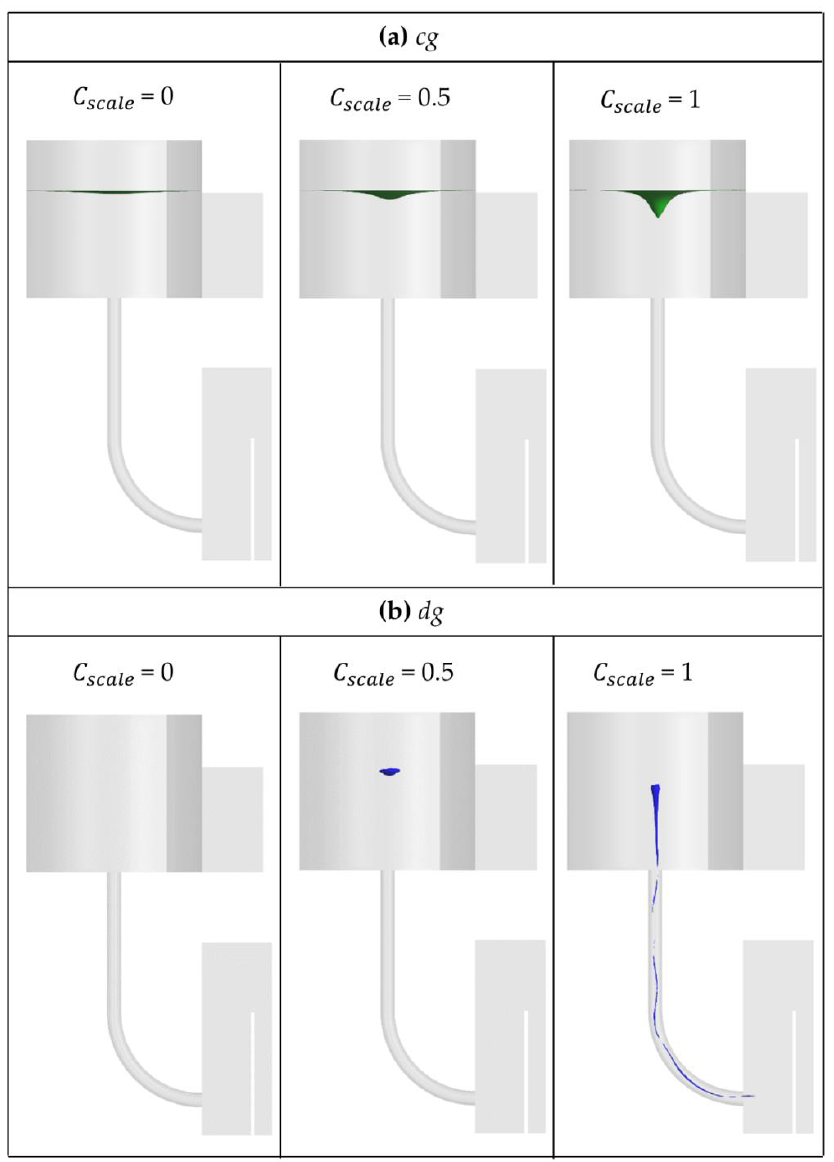
Figure 4. ( a ) Average interfacial deformation represented by iso-surface of α cg = 0.5 and ( b ) average bubble entrainment represented by iso-surface of α dg = 0.02. The results are obtained from the simulations using C ent = 2 × 10 − 4.